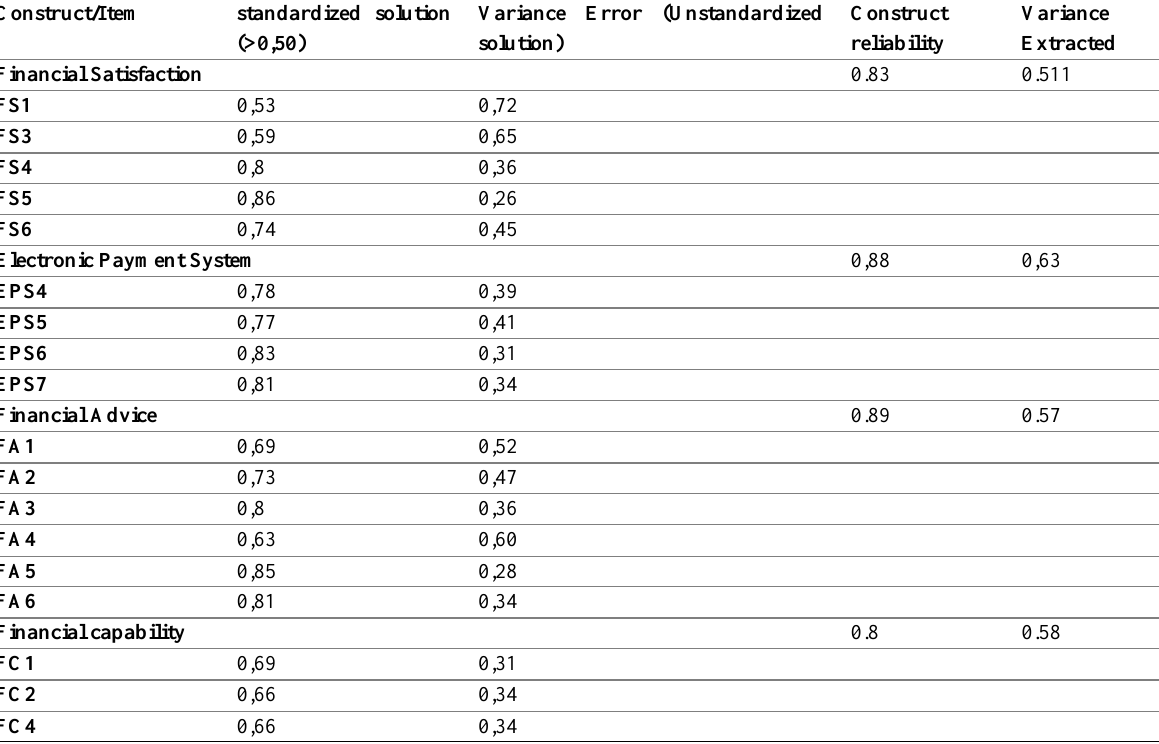
Table 1: Confirmatory Factor Analysis